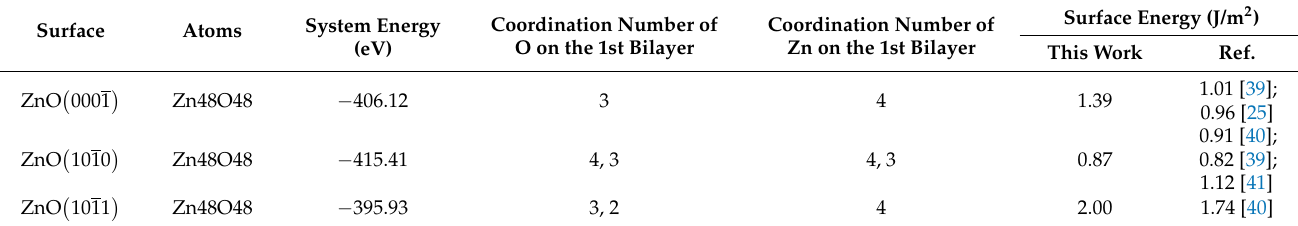
(cid:0) (cid:1) (cid:0) (cid:1) 0001 , ZnO 1010 and ZnO